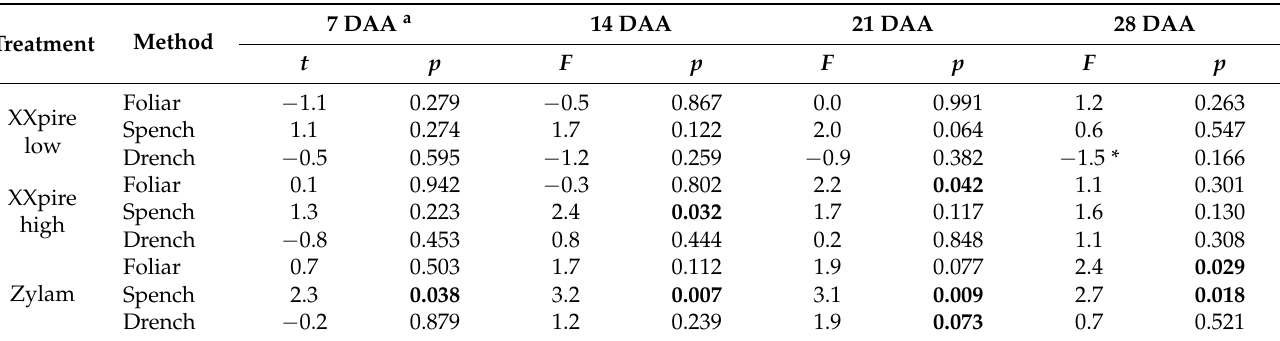
Table 2. All densities of B. tabaci observed on poinsettia leaves treated, with the specific insecticide– method combination compared with nontreated check treatment in the greenhouse, were analyzed using Student’s t